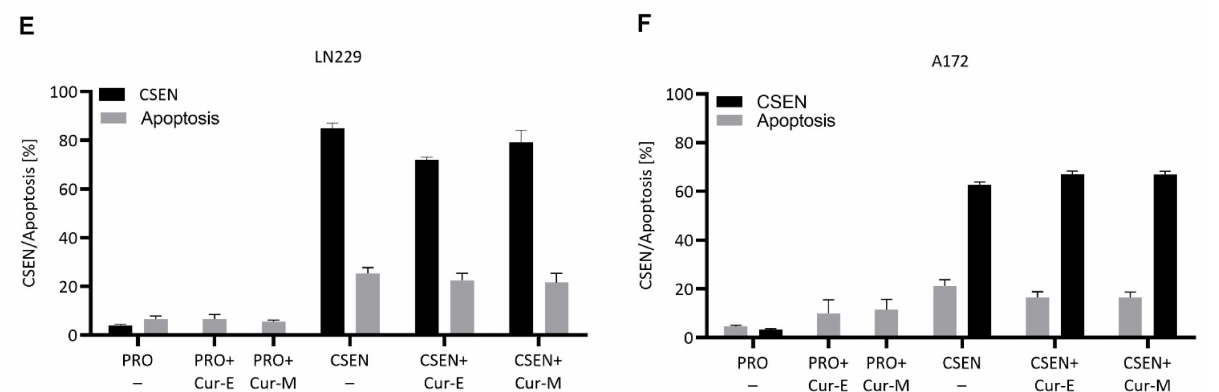
Figure 7. Effect of natural compounds on senescent cells. Treatment of proliferating (PRO) and senescent (CSEN) LN229 and A172 cells with fisetin ( A , B ) and artesunate ( C , D ) leads to a significant decrease in senescence and increase in apoptosis, while treatment with curcumin (10 µ M) was without effect ( E , F ). Cur-E, curcumin solubilized in ethanol; Cur-M, curcumin embedded in micelles. Without treatment ( − ). Data represent the mean of >3 independent experiments ± SEM. * p < 0.05, ** p <